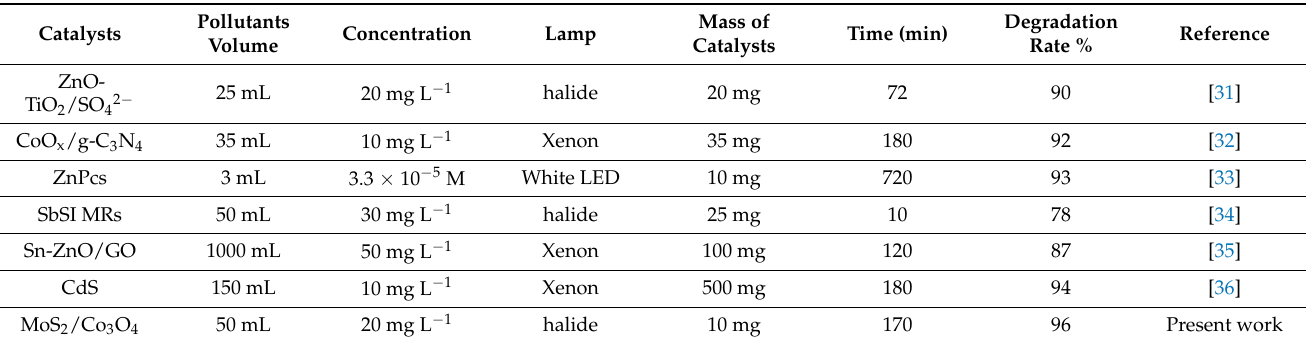
Table 2. Comparison of photocatalytic activity of some photocatalysts for removal MO dye under visible light